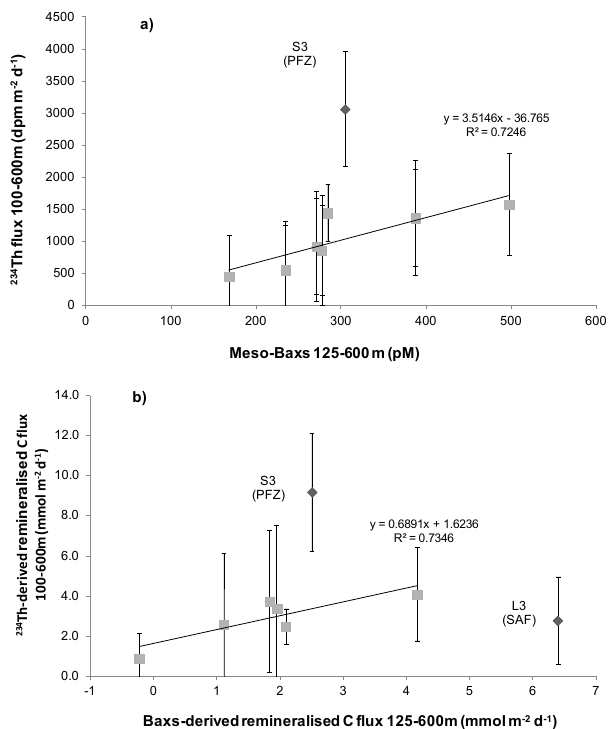
Fig. 9. (a) Depth-weighted average mesopelagic excess Ba (meso- Ba xs ; pM, 125–600m) versus mesopelagic 234 Th accumulation flux (100–600m); (b) C remineralisation flux deduced from Ba xs (C respired in mmolCm − 2 d − 1 ) plotted versus C remineralisation flux (in mmolCm − 2 d − 1 ) deduced from 234 Th excess activity in the mesopelagic layer (100–600m) and the POC/ 234 Th p ratio (µmoldpm − 1 ) of > 53µm particles.